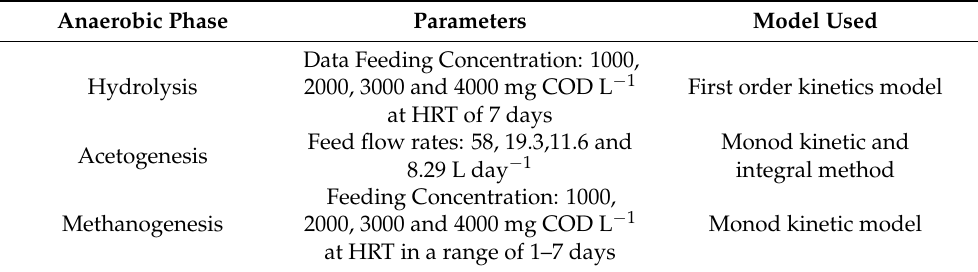
Table 1. Parameters for the kinetic study of anaerobic digestion phases. Anaerobic Phase